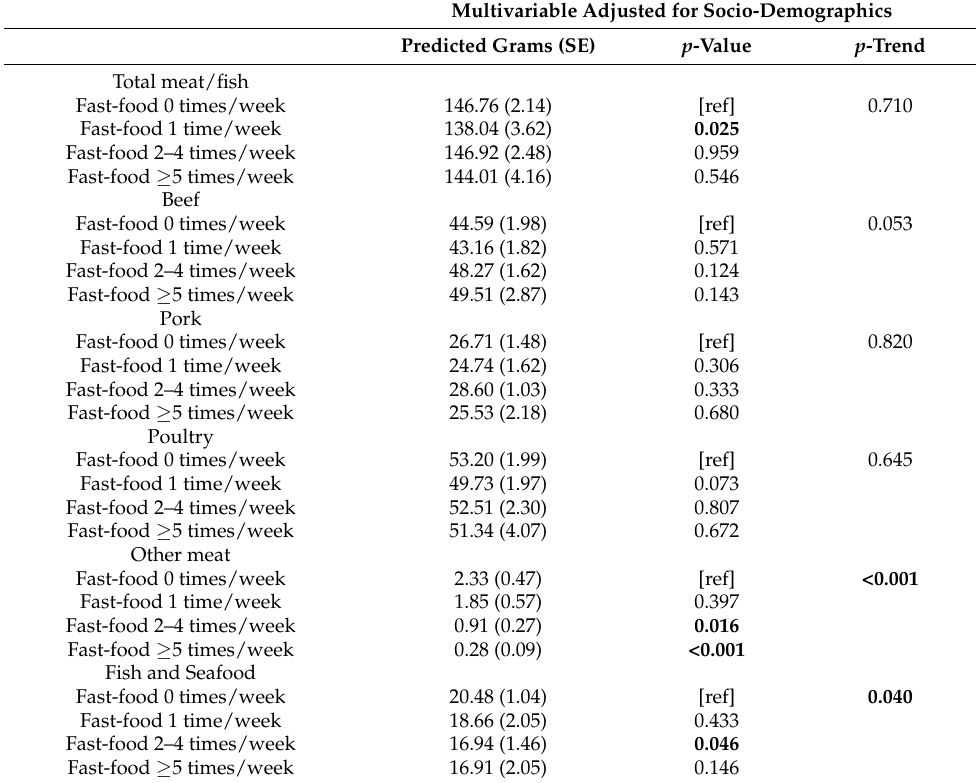
Table A4. Meat, Fish and Dairy Consumption (Grams Per 2000 kcal) by Fast Food Frequency, NHANES